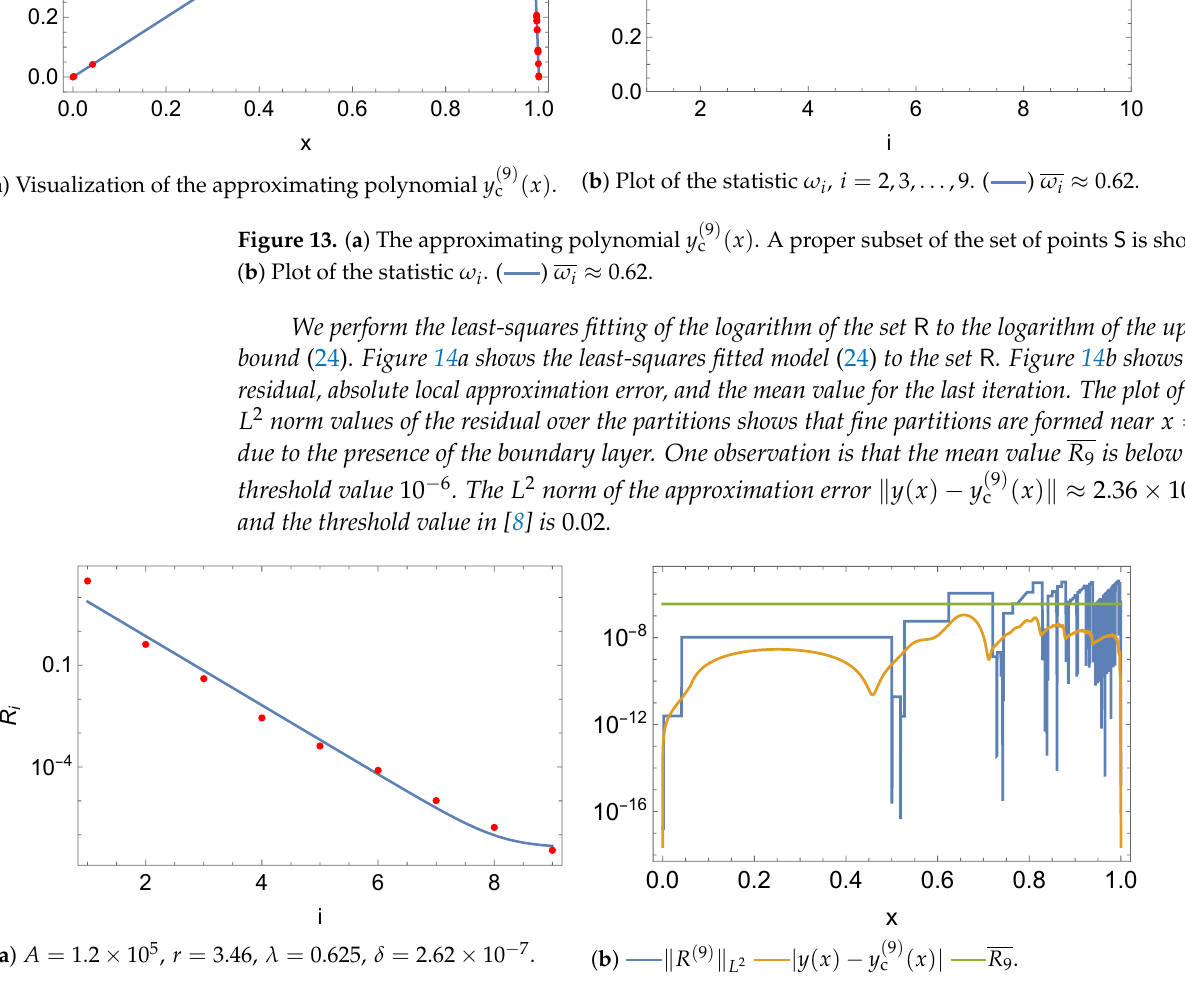
Figure 14. ( a ) Fitting the upper bound (24) with the set R . ( b ) Visualization of the residual, absolute local approximation error, and the mean